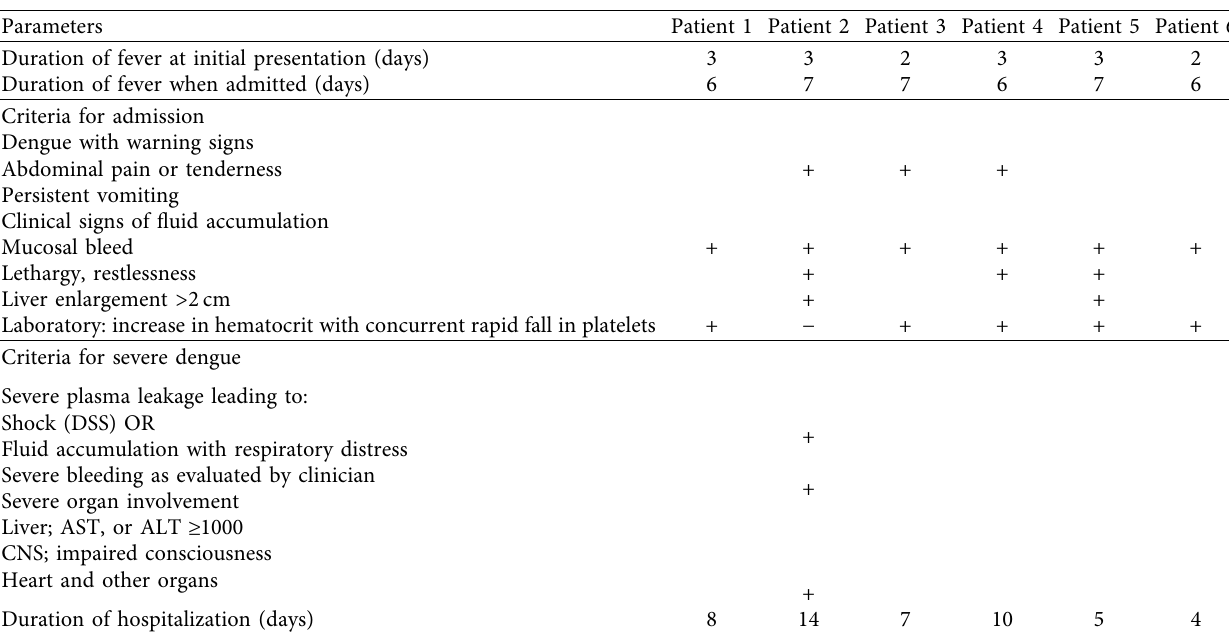
Table 3: Identification of admission criteria among six children with dengue fever managed on outpatient basis that showed signs of deterioration on follow-up 1